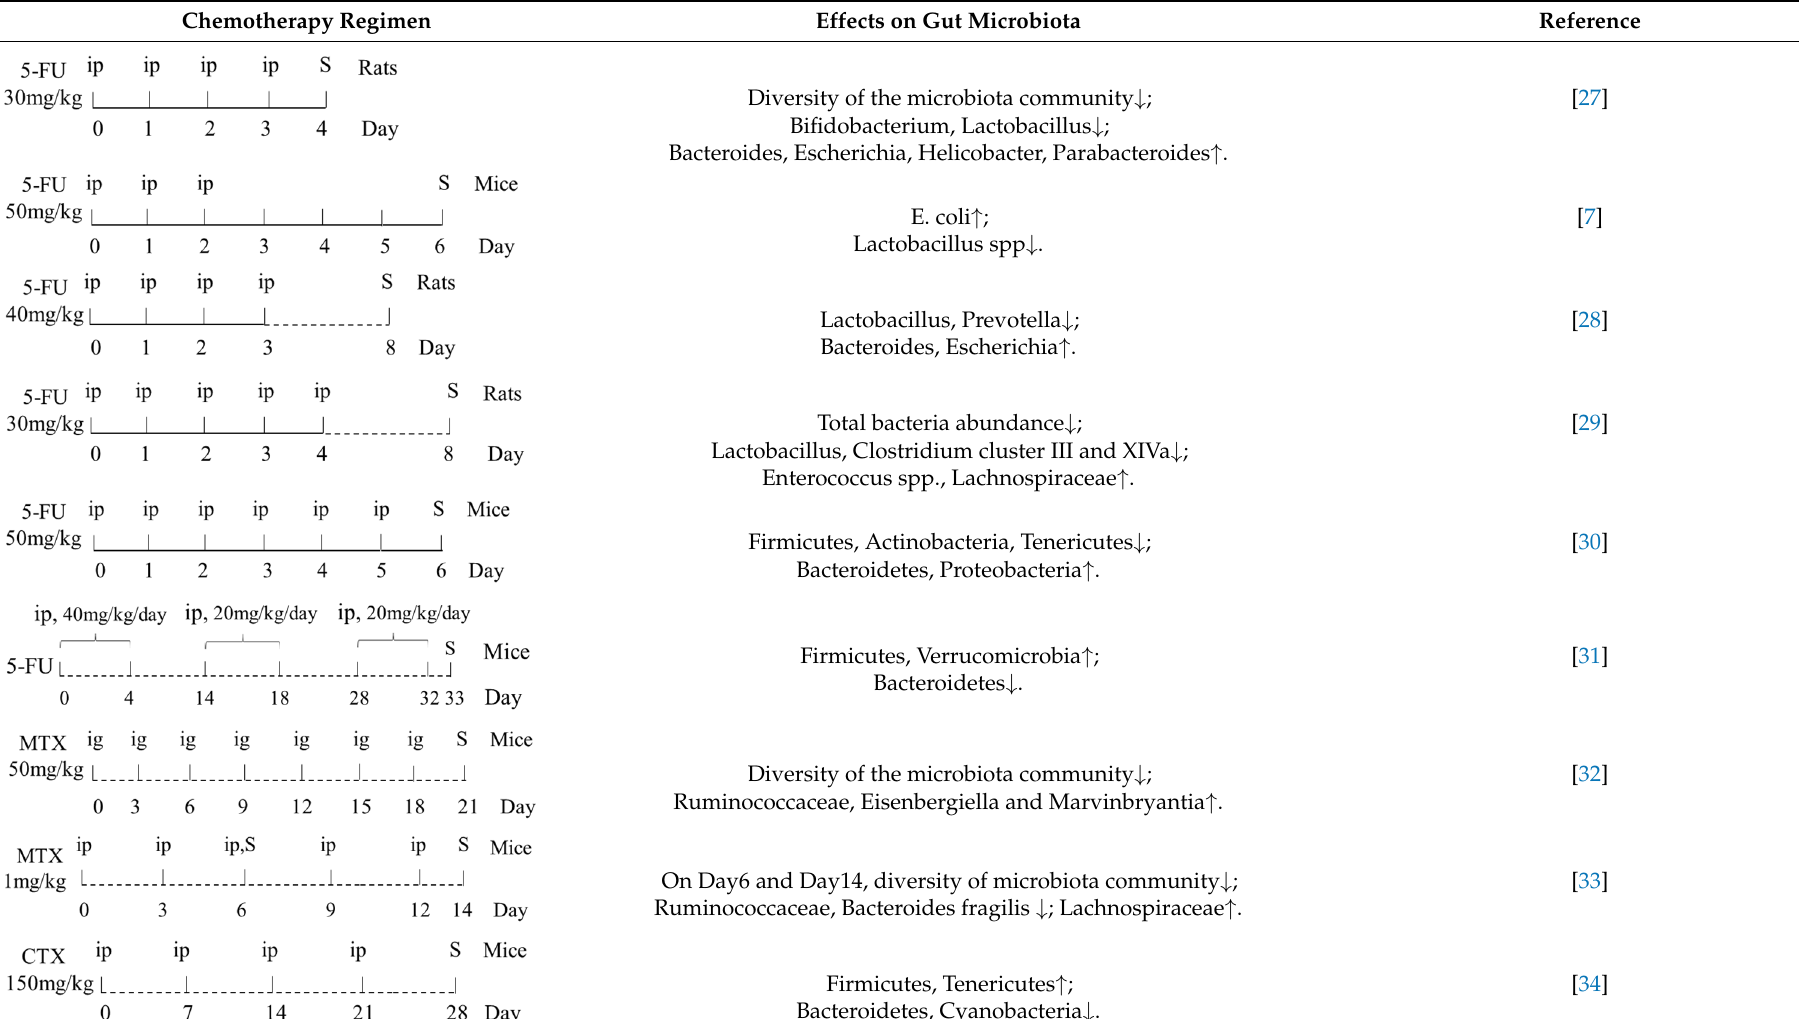
Table 1. Effects of different chemotherapeutic regimens on intestinal microbiota in animal experiments. Chemotherapy Regimen